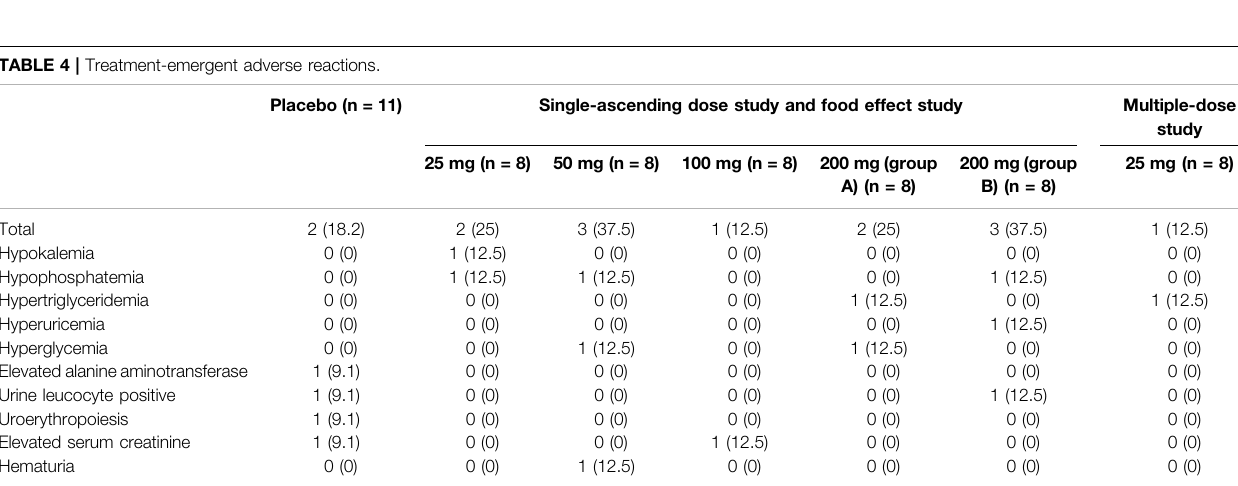
FIGURE 3 | Mean values of plasma hepenofovir and tenofovir concentration-time pro fi les in each treatment group for the multiple-dose study. Data illustrations included: mean (± standard deviation [SD]) hepenofovir plasma concentration-time pro fi les (A) and tenofovir plasma concentration-time pro fi les (B) .